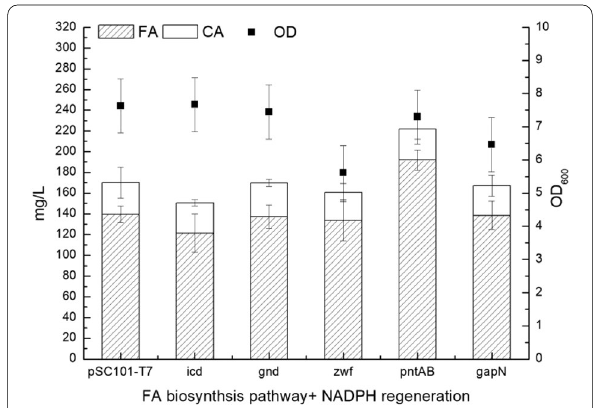
Fig. 4 Comparison of FA biosynthesis strains co-expressed with NADPH regenerating enzymes. pSC101-T7 refers to FA biosynthesis pathway plasmid pBR322-T5-tal-sam5-comt co-expressed with plasmid pCL1920-T7 in host cell JM109(DE3); icd refers to FA biosynthesis pathway plasmid pBR322-T5-tal-sam5-comt co-expressed with plasmid pCL1920-T7- Ecicd in host cell